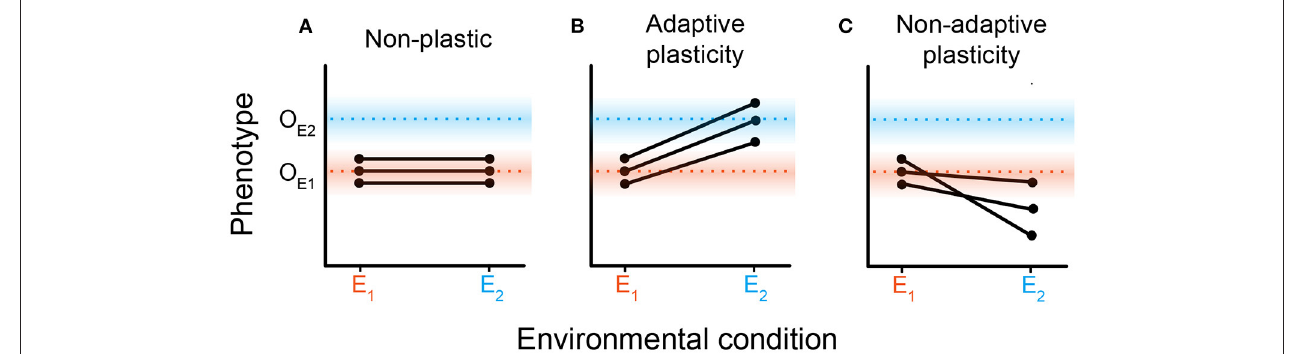
FIGURE 1 | Hypothetical reaction norms for populations comprising genotypes placed in different environments. A reaction norm describes phenotypic change (or lack thereof) induced by environmental variation (West-Eberhard, 2008). In all panels, two environmental conditions (denoted E 1 and E 2 ) are shown on the x-axis. The y-axis indicates the phenotype expressed in each environment with O E1 and O E2 designating the optimal phenotype for E 1 and E 2 , respectively. Each pair of points connected by a solid black line denotes a genotype, with the points themselves representing its hypothetical phenotypes in each environment. We present three scenarios for how populations could respond to a change from E 1 to E 2 . (A) A non-plastic population where phenotypes do not change with environmental shifts. (B) An adaptively plastic population where phenotypes dynamically adjust to the new optimum. (C) A population exhibiting non-adaptive plasticity where environmental change induces phenotypes further away from the